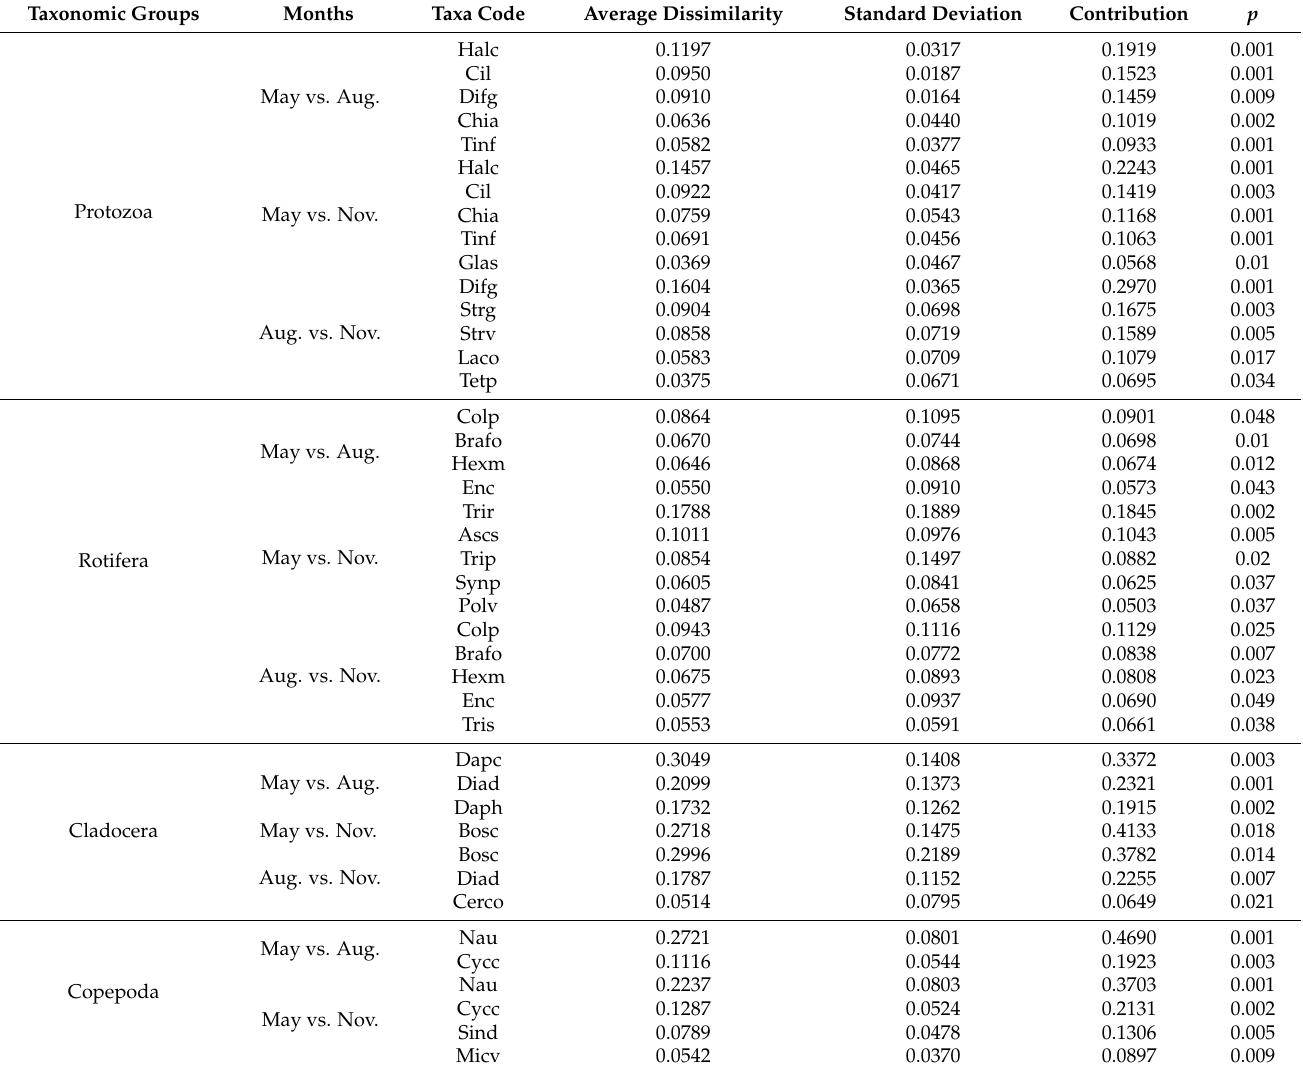
Table A3. Results of SIMPER analysis for taxa with contribution to the variation among the three sampling months > 5% and p < 0.05, based on the four taxonomic